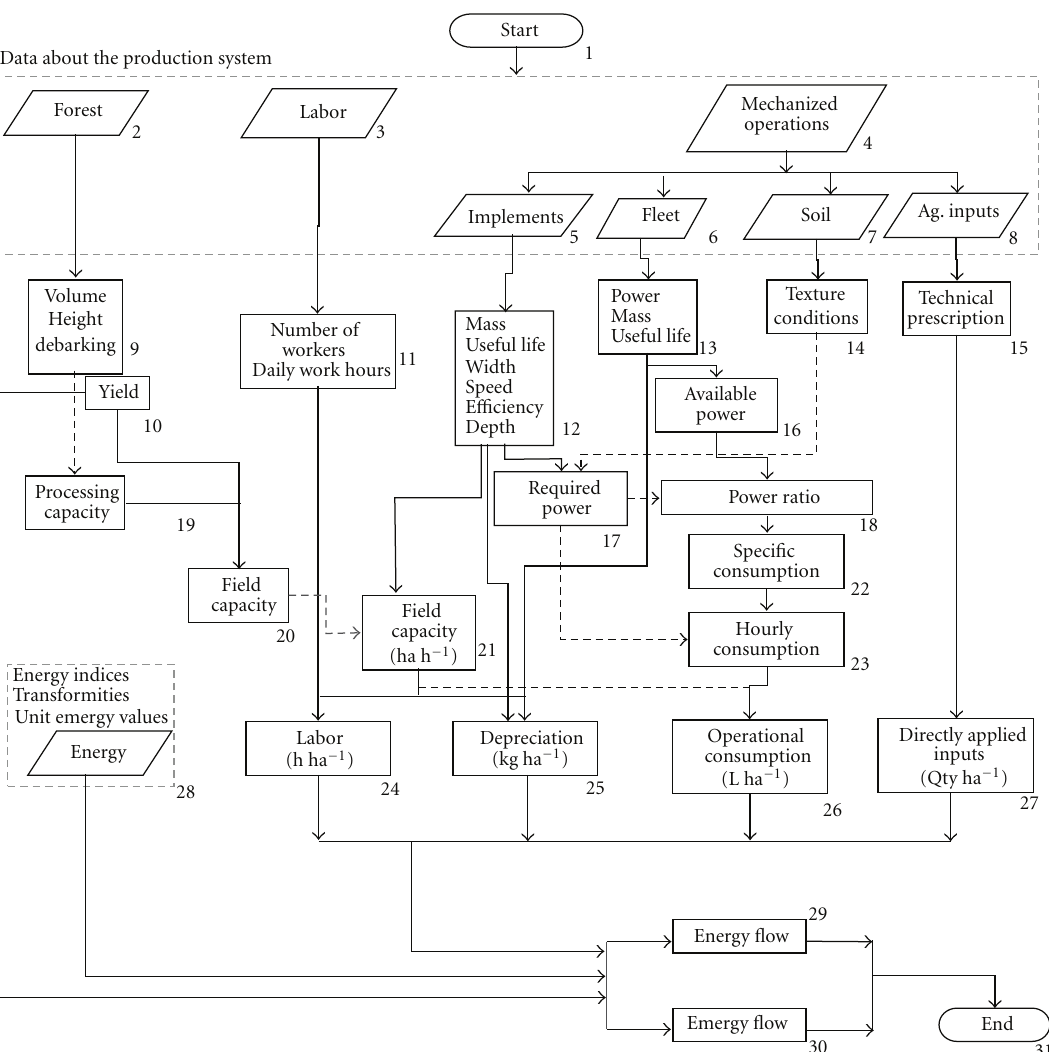
Figure 1: Flow chart developed to determine energy and emergy flows